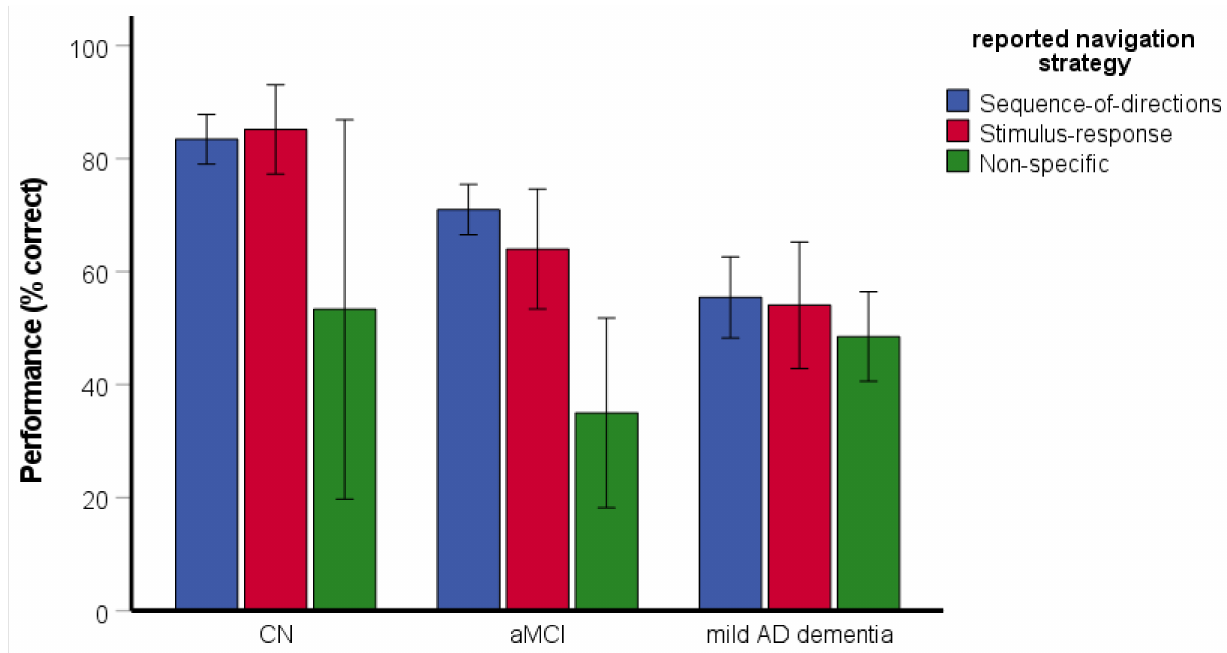
Figure 3. Route-repetition task—the effect of reported strategy on spatial navigation performance. CN, cognitively normal; aMCI, amnestic mild cognitive impairment; mild AD dementia, mild Alzheimer’s disease